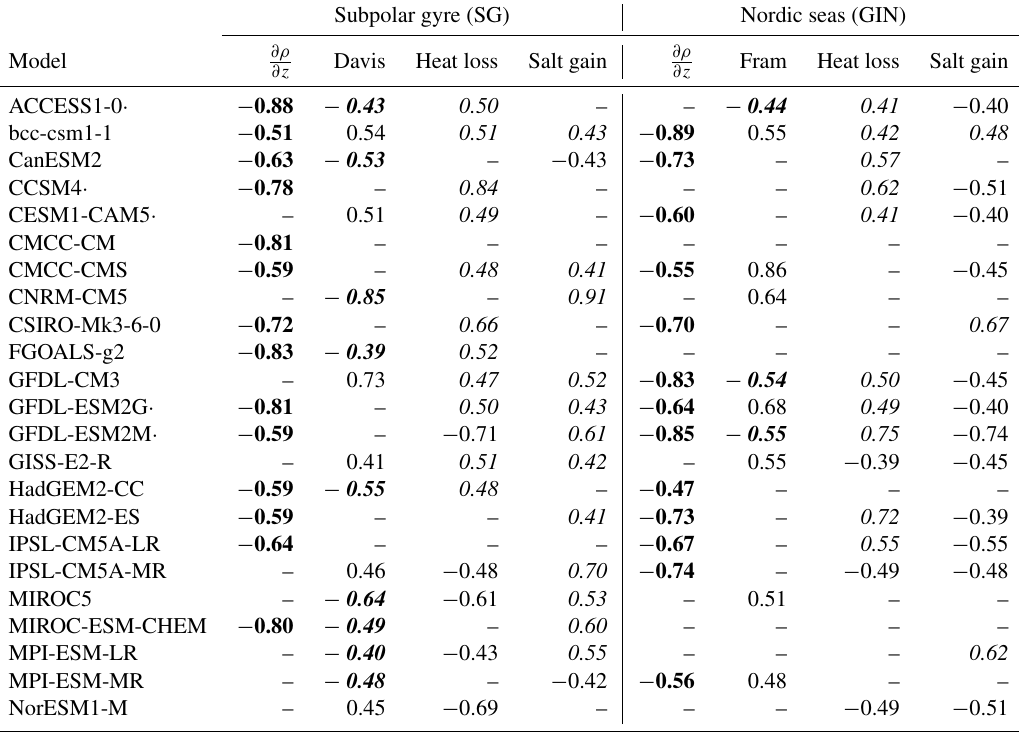
Table 2. For each model, for the subpolar gyre SG (left) and the GIN seas (right), significant correlation (if any) between the time series of , the Arctic freshwater export via Davis (left) or Fram (right) straits, the the winter mixed layer depth and the local vertical density gradient ∂ρ ∂z local heat exchange with the atmosphere and the local surface salinity change. Different font styles highlight correlation that could explain deep water formation in each model. Sign conventions: negative with ∂ρ or freshwater means that low stratification or freshwater transport ∂z correspond to deep mixed layers; positive correspond to heat loss or salt gain if an ocean surface cooling or salinification corresponds to deep mixed layers. Models featuring the Fox-Kemper et al. (2011) mixed layer parameterisation are indicated by a black bullet after their